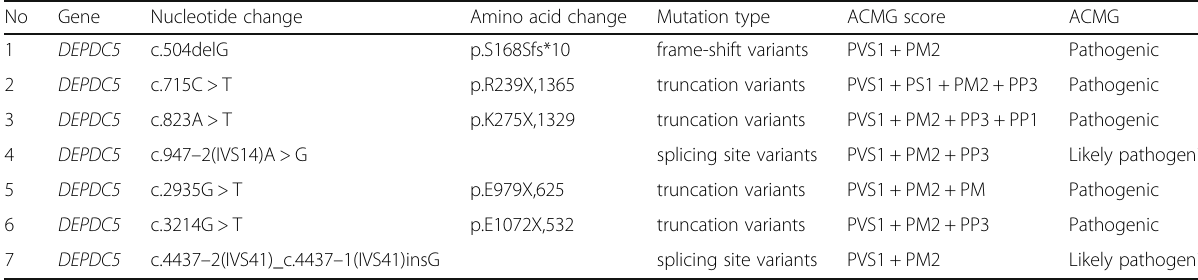
Table 1 Variants found in seven